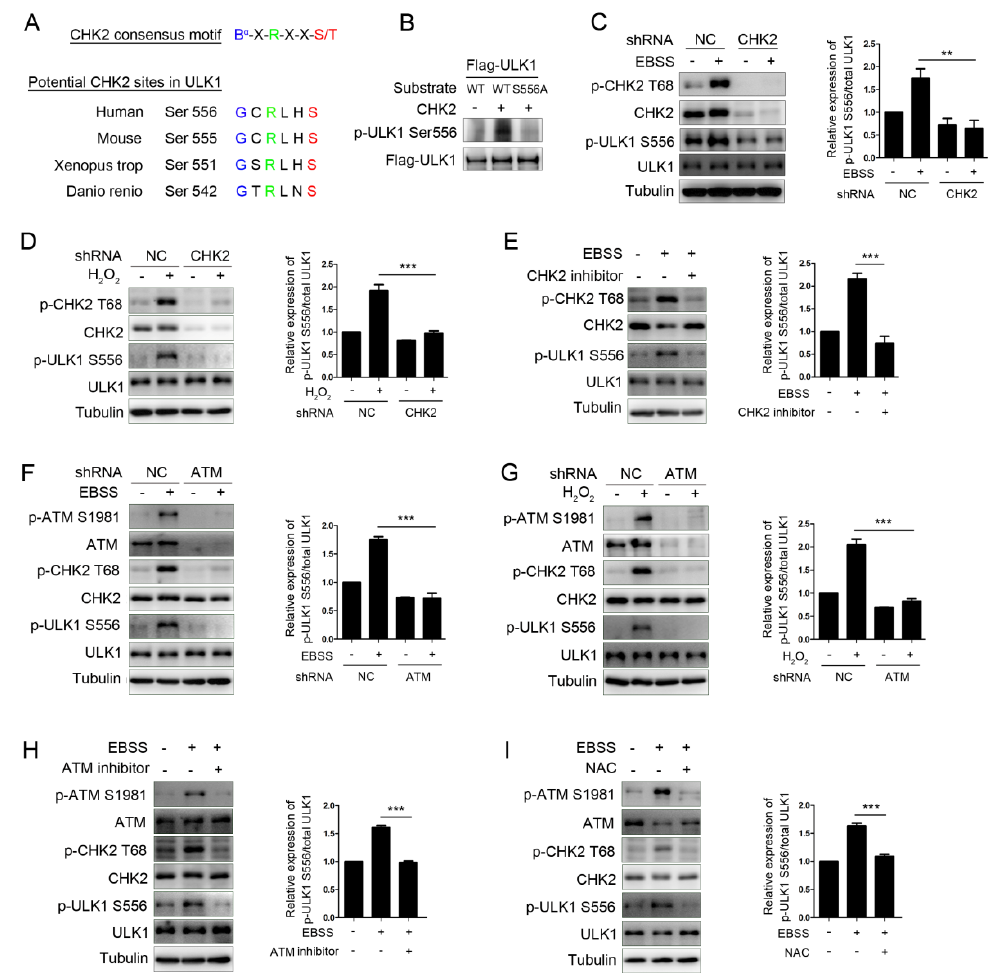
Figure 2. CHK2 phosphorylates ULK1 at Ser556. ( A ) Clustal alignment of the conserved sites in ULK1 matching the optimal CHK2 substrate motif. ( B ) In vitro CHK2 kinase assay using CHK2 recombinant human protein with FLAG-ULK1WT and FLAG-ULK1S556A as substrates, followed by immunoblotting analysis. ( C , D ) Western blot analysis with the indicated antibodies in H1299 cells with CHK2 knockdown. Cells were treated with EBSS ( C ) or H 2 O 2 (500 µ M) ( D ). ( E ) Western blot analysis with indicated antibodies in H1299 cells pretreated with CHK2 inhibitor for 3 h and treated with EBSS for 1 h. ( F , G ) Western blot analysis with indicated antibodies in H1299 cells with ATM knockdown. Cells were treated with EBSS ( F ) or H 2 O 2 (500 µ M) ( G ). ( H ) Western blot analysis with the indicated antibodies in H1299 cells pretreated with ATM inhibitor for 3 h and treated with EBSS for 1 h. ( I ) Western blot analysis with the indicated antibodies in H1299 cells pretreated with NAC for 4 h and treated with EBSS for 1 h. The results from three independent experiments are presented as mean ± SEM. ** p < 0.05, *** p <